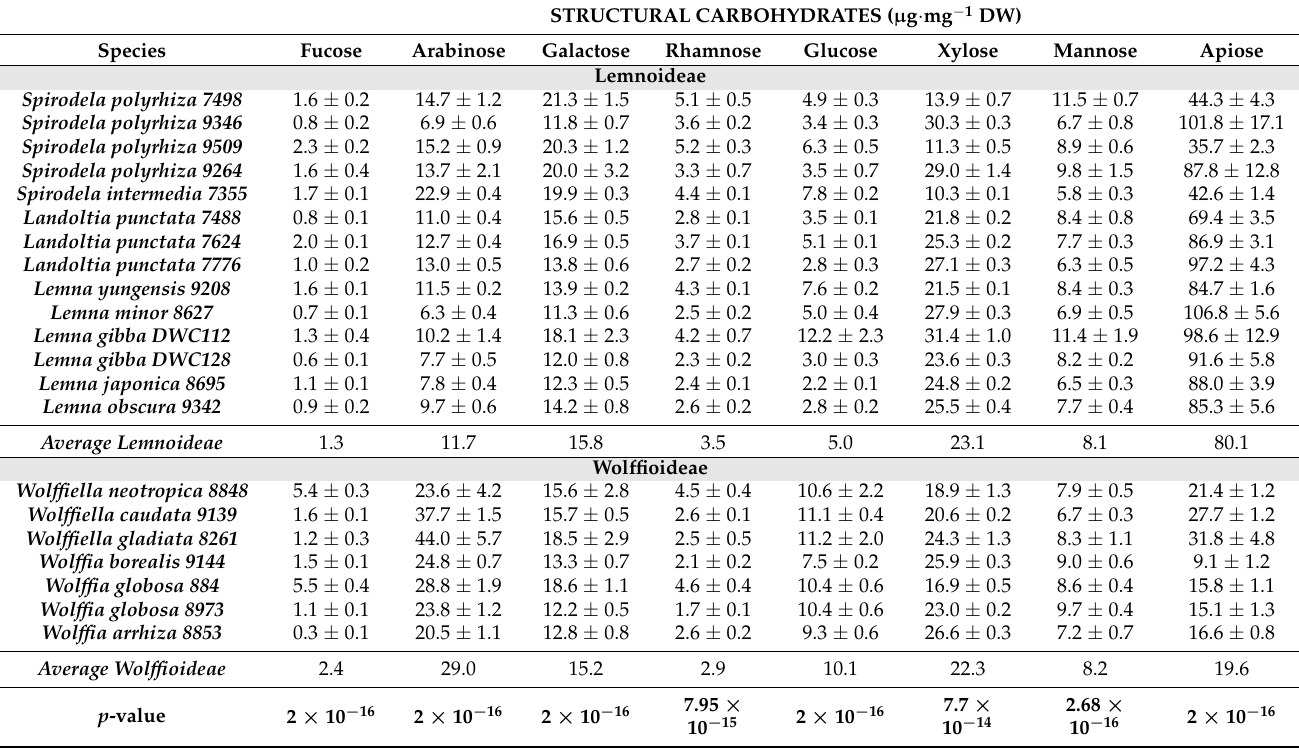
Table 3. Structural carbohydrates composition of 21 ecotypes of duckweeds. Data represented by the mean ± standard error ( n =